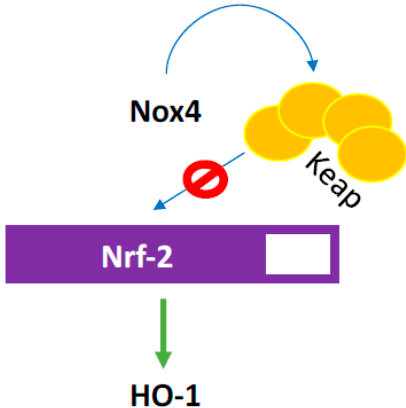
Figure 13. ROS induces Keap oxidation which, in turn, prevents degradation of Nrf-2 transcription factor that increases hemoxygenase 1 (HO-1) expression. HO, a critical enzyme that performs several critical functions within vascular cells including heme degradation and, in turn releasing bile pigments and carbon monoxide, has significant antioxidant and signaling effects in its active and inactive